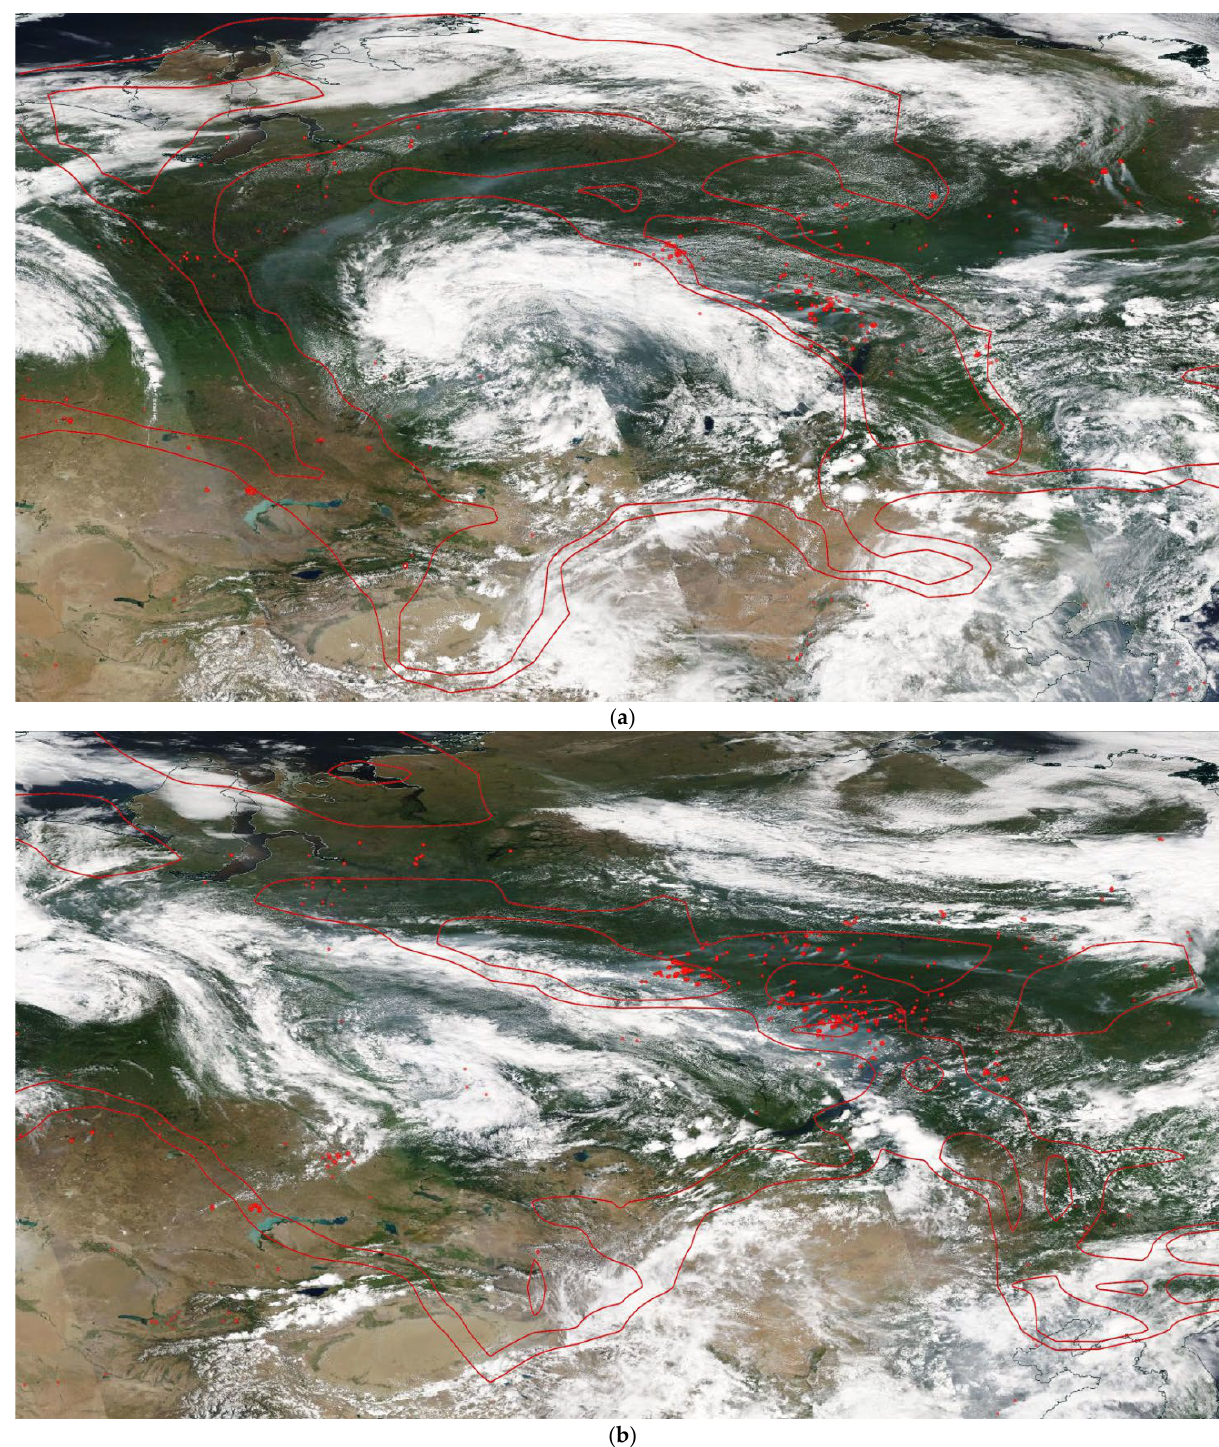
Figure 11. Worldwide maps with the hotspots position and schematic PV breaking (2 and 7PVU) according to Era-Interim on 16 July 12 UTC ( a ), 17 July 12 UTC ( b ), 60–120 E, 30–70 N, Era-Interim data.